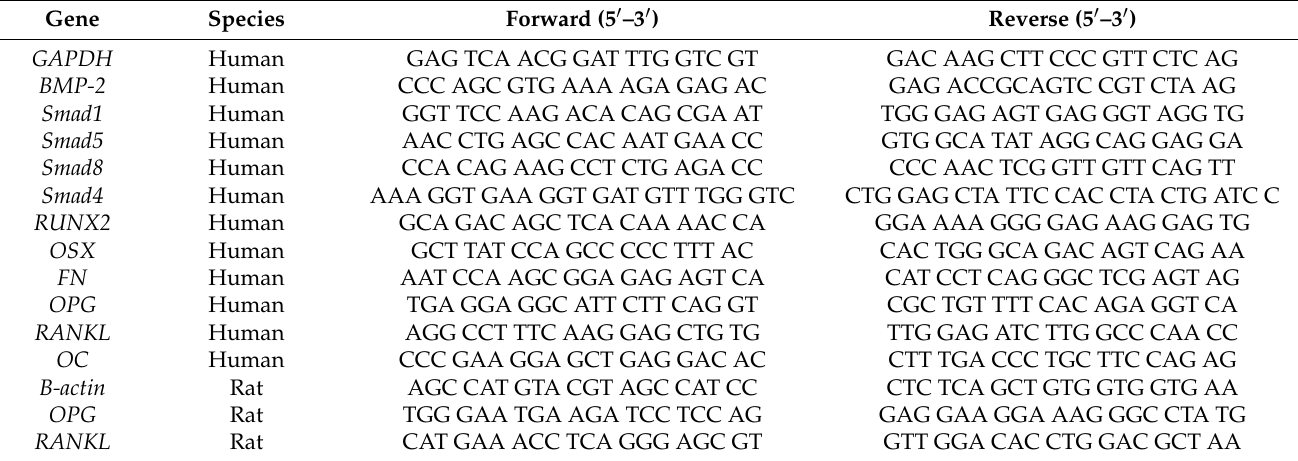
Table 1. Primer sequences used for